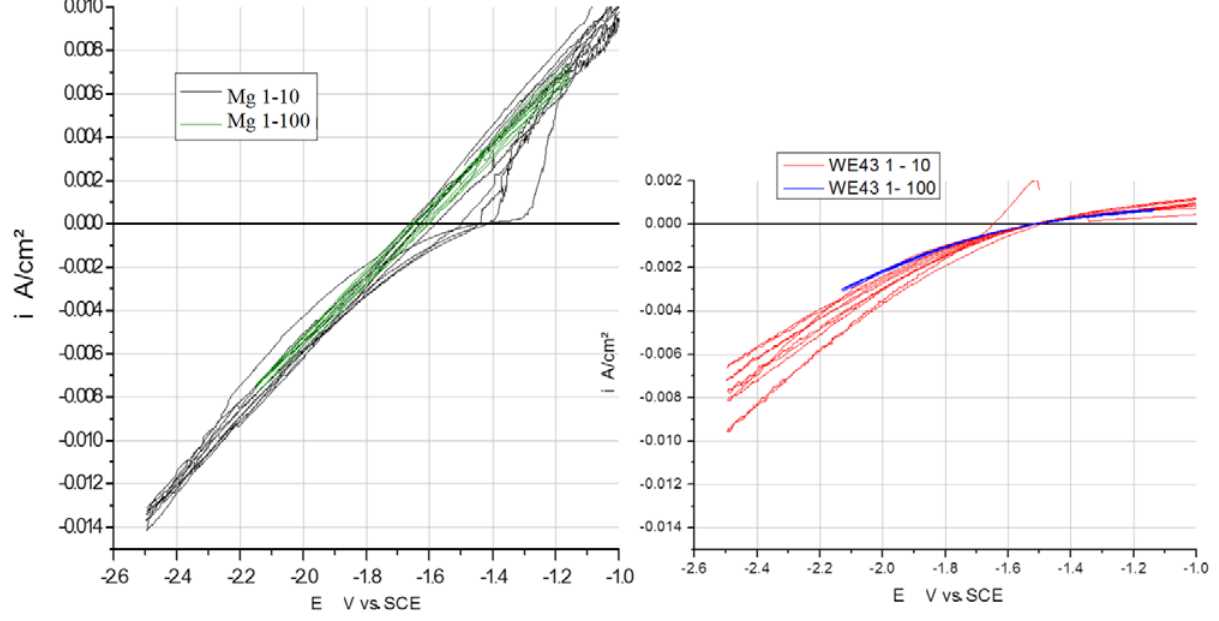
Figure 4. Linear, scaled presentation of cyclic I vs. E curves of pure Mg ( left ) and WE43 ( right ) performed with two different scan rates, 10 and 100 mV/s, in Ringer’s